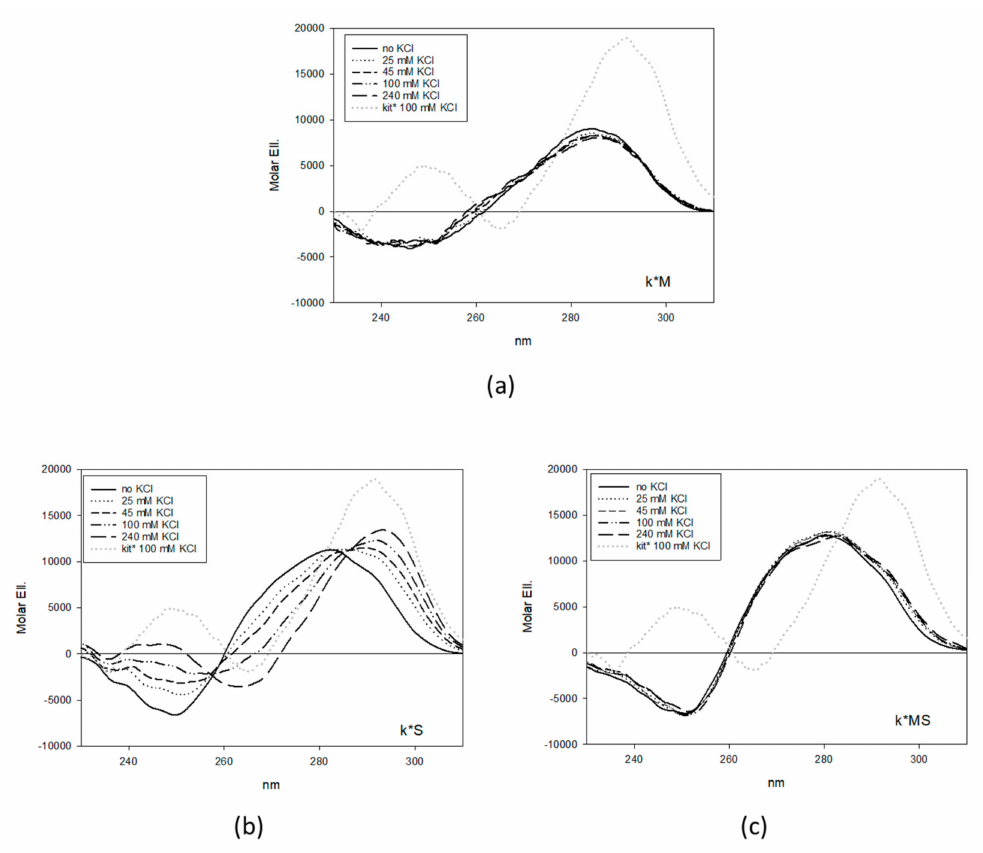
Figure 2. CD titrations of 4 µ M k*M ( a ), k*S ( b ) and k*MS ( c ) with increasing concentrations of KCl in 10 mM Tris, pH 7.5, 25 ◦ C. Grey dotted lines refer to the corresponding wild type sequences in 100 mM